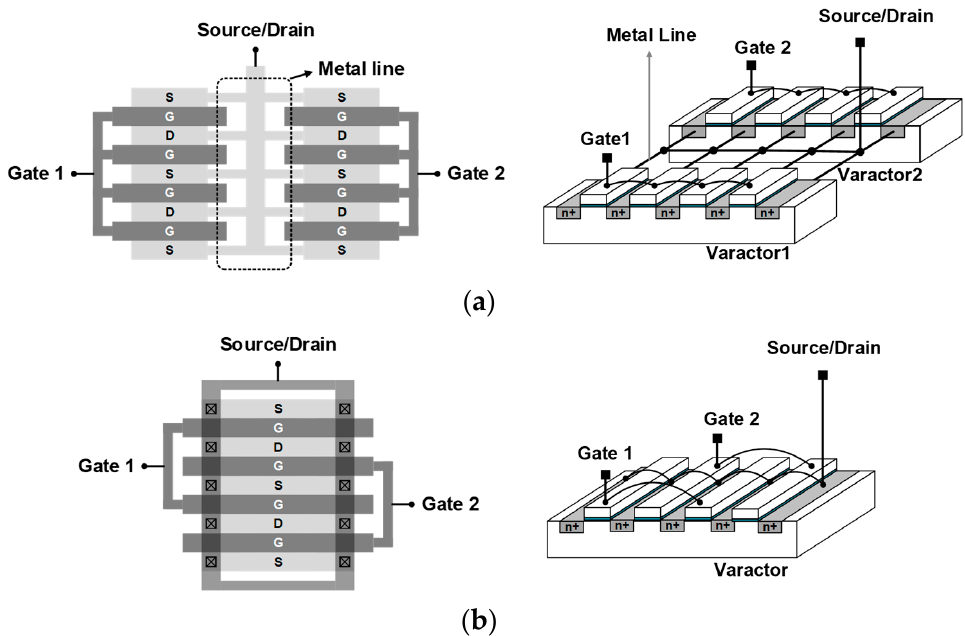
Figure 4. Conceptual layouts of ( a ) typical and ( b ) proposed MOS varactors.